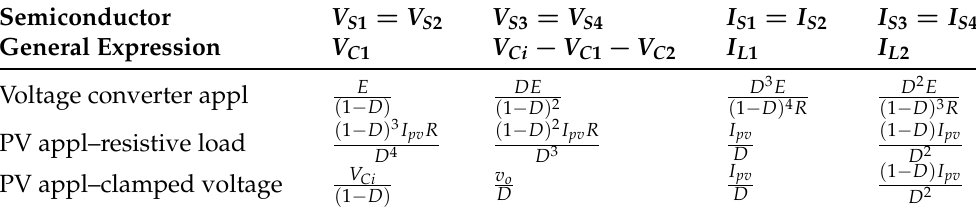
Table 1. Voltage and current stress on a semiconductor